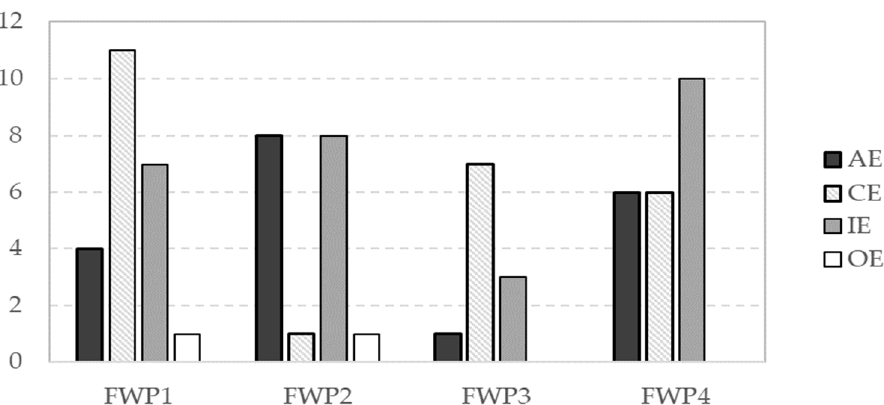
Figure 8. Distribution of the errors (arithmetic errors, conceptual errors, Interpretation errors and other errors) in the written solution of preservice primary teachers according to the fraction word problem.